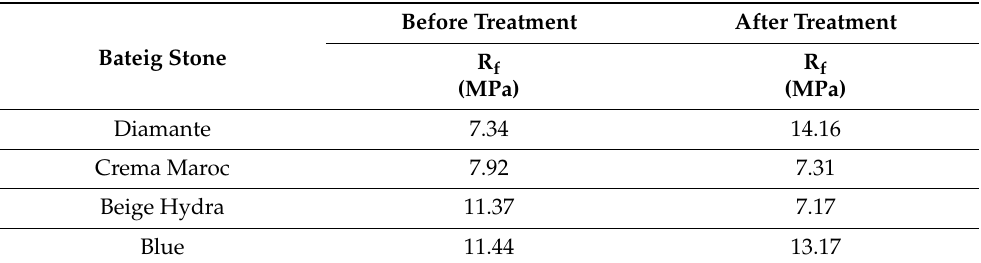
Table 15. Comparison between the values of the flexural strengths before and after the treatment of Bateig stone specimens (mean